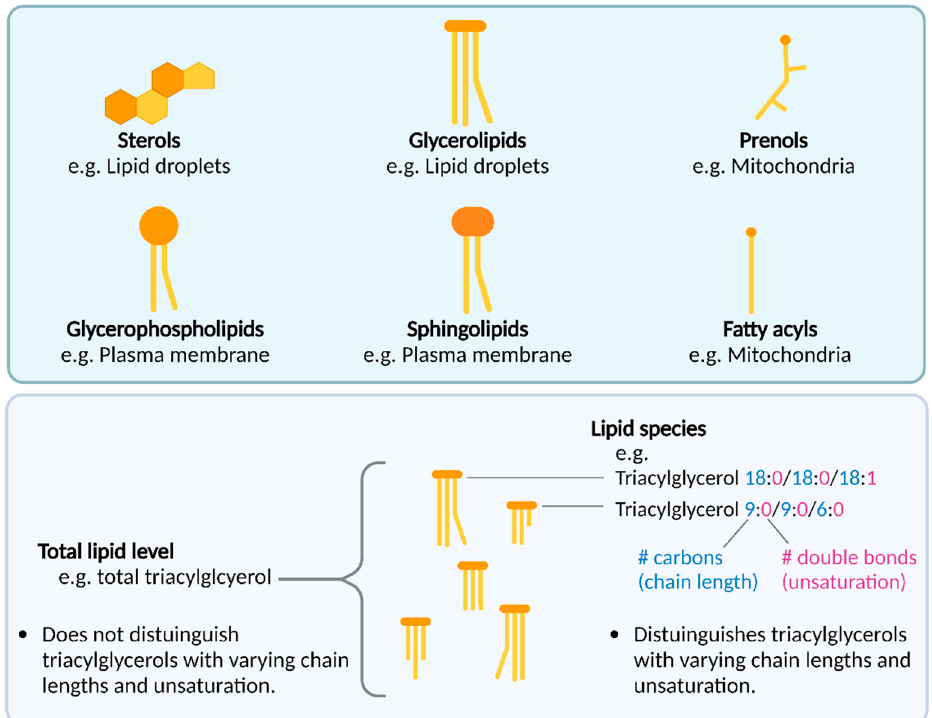
Figure 1. Top panel: Lipid categories and examples of their cellular location. Bottom panel: Enzymatic and chemical assays can measure total lipid levels, while mass spectrometry techniques can discern the levels of specific lipid species, which have varying degrees of unsaturation and carbon chain lengths. Created with BioRender.com (accessed on 26 Oct 2022).